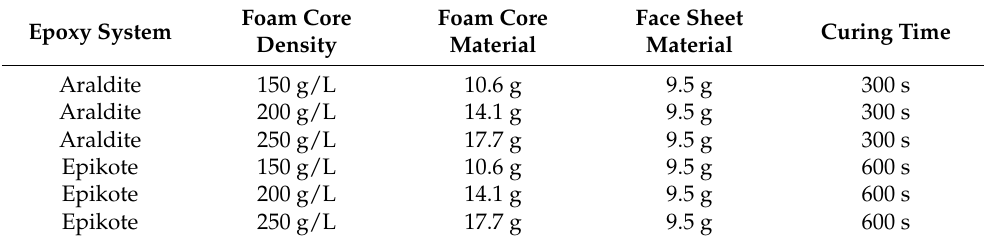
Table 1. Investigated trial